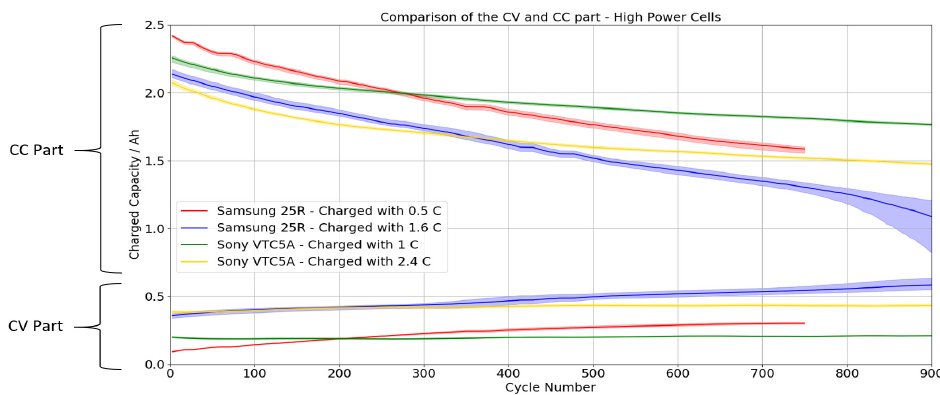
Figure 9. Development of the capacity charged during the cycle test. Separation of the CC and CV part for high power cells.